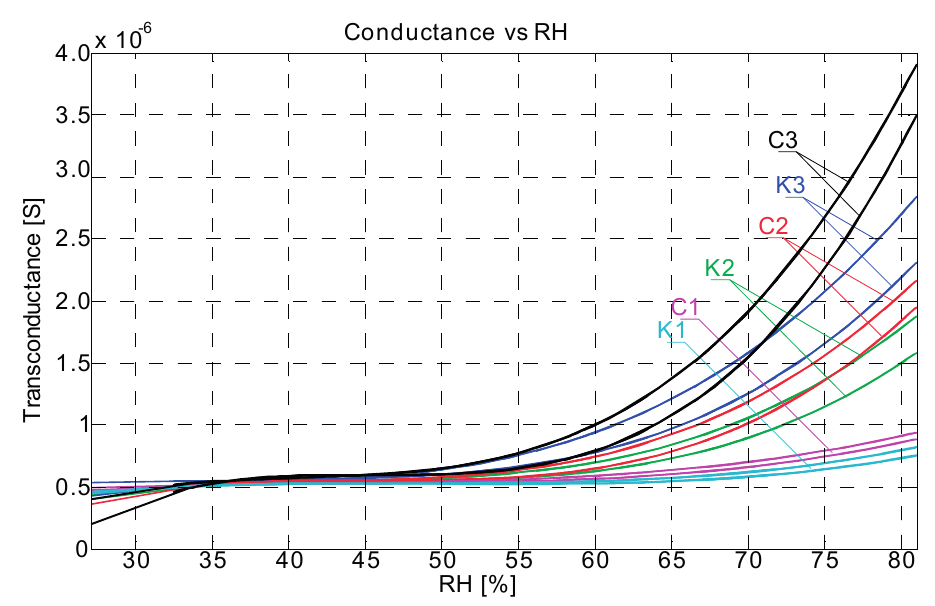
Figure 9. Conductance vs relative humidity plot.